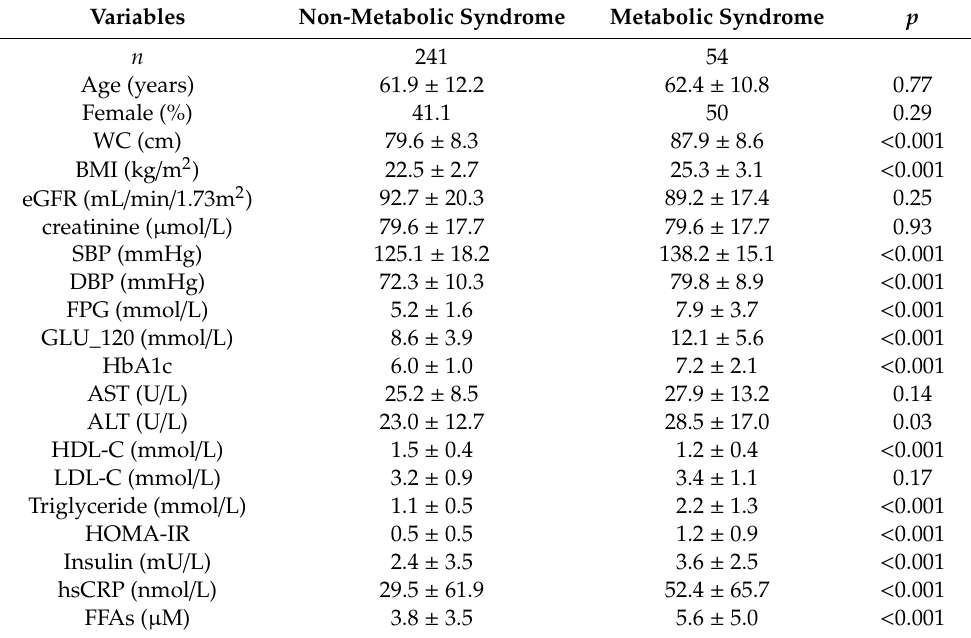
Table 1. Comparisons of clinical characteristics between